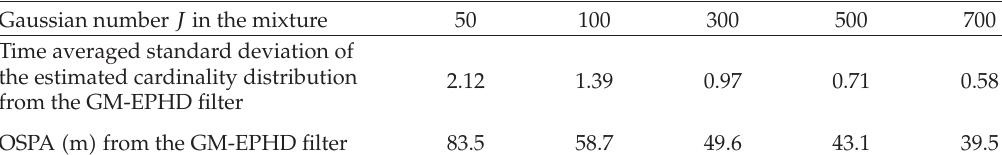
Table 2: Time averaged standard deviation of the estimated cardinality distribution and time averaged OSPA (cid:2) m (cid:3) from the GM-EPHD filter in various λ given J (cid:8) 700. Clutter rate λ 50 Time averaged standard deviation of the estimated cardinality distribution from the GM-EPHD